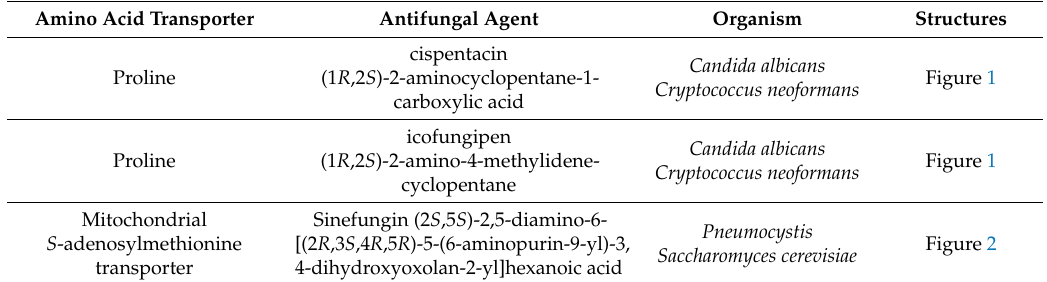
Table 1. Selected Amino Acid Transporters and Potential Pharmacological Targets of Antifungal Therapy.